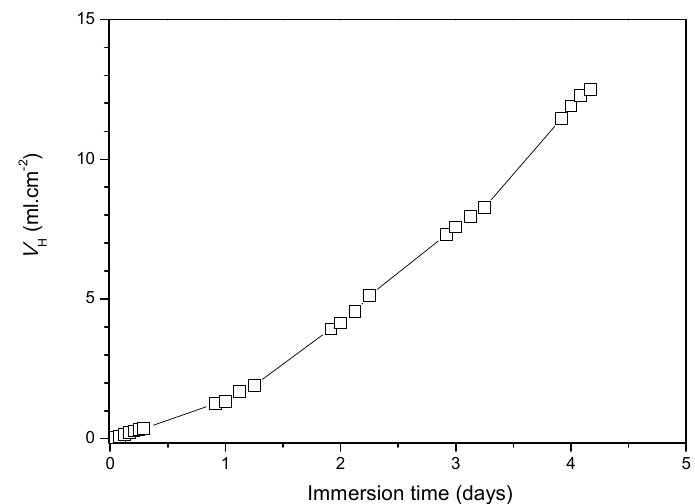
Figure 4. Volume of hydrogen evolution from AZ31B after immersion in Ringer ′ s solution (37 °C) for 4 days.